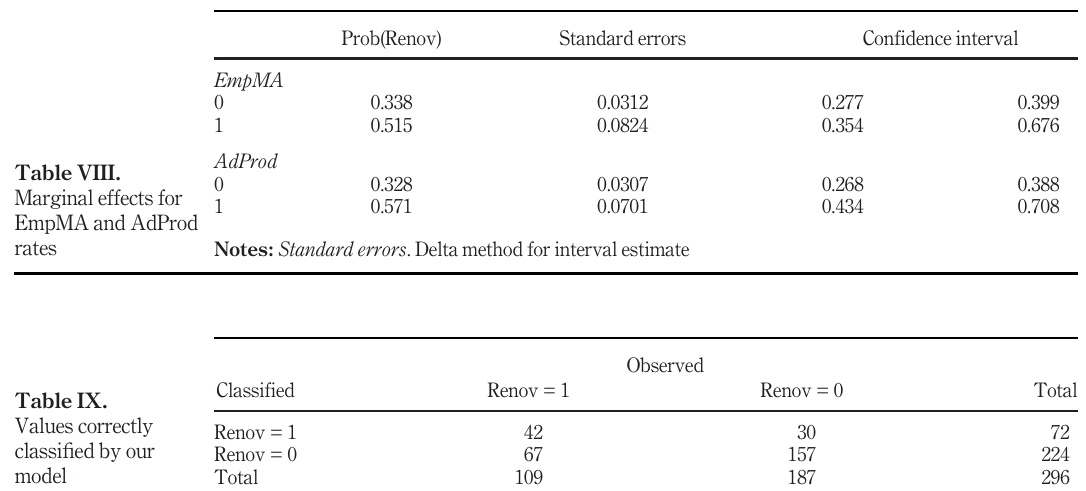
Table IX. Values correctly classi fi ed by our model